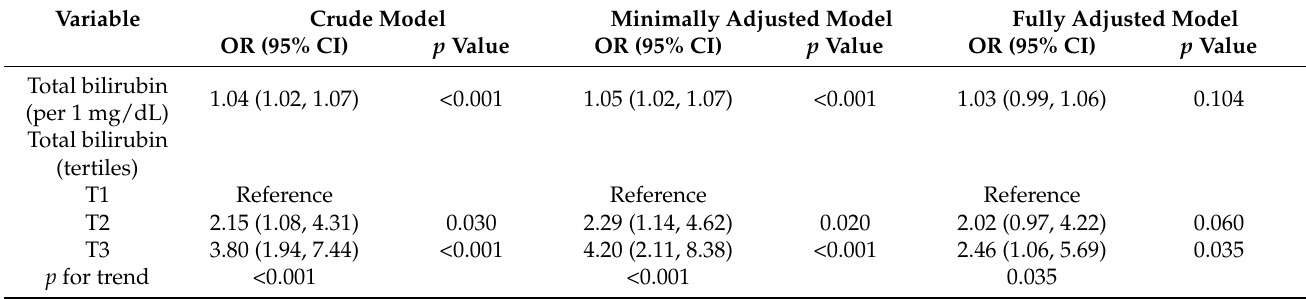
Table 3. Relationship between total bilirubin and post-transplant delirium in different models.